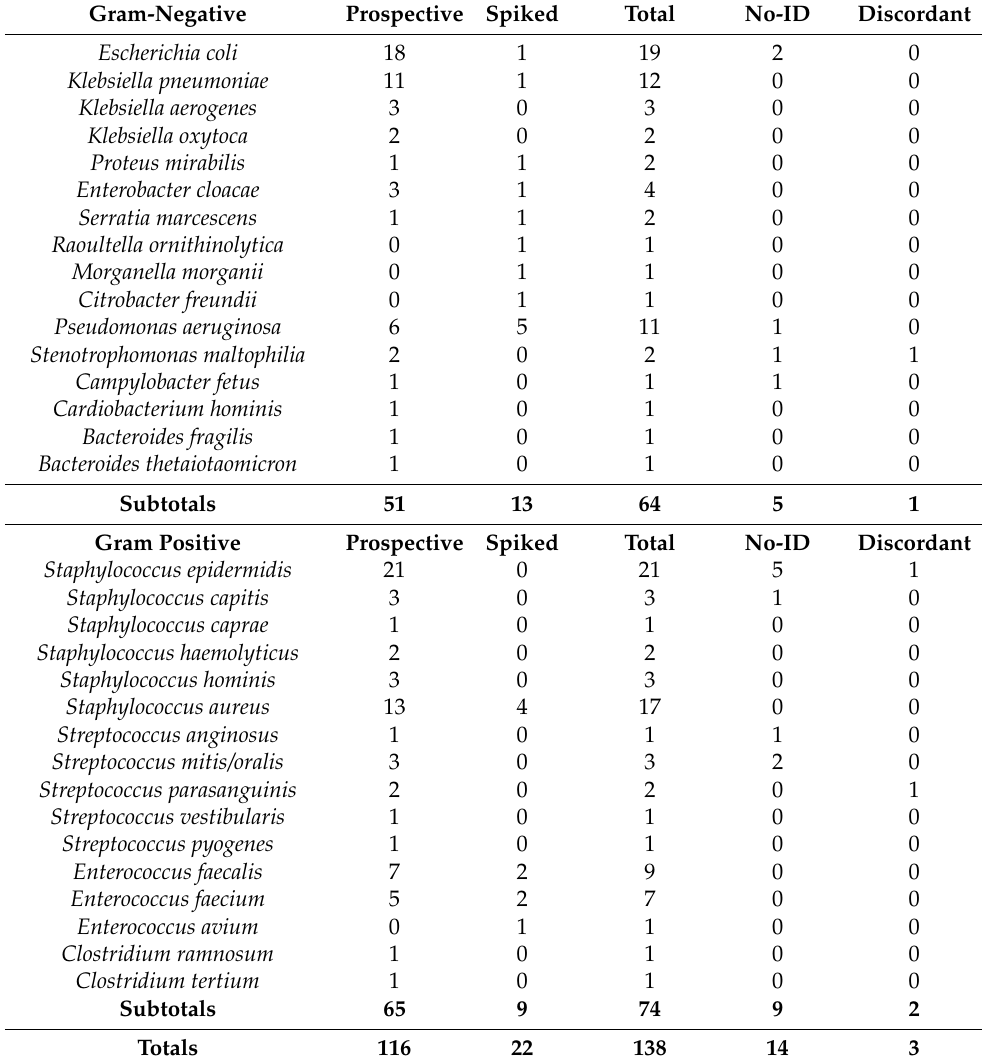
Table 1. VITEK MS Results for Samples Included in Study by Species.